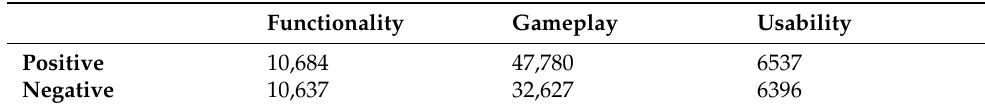
Table 5. Data volume for review subsets for Release